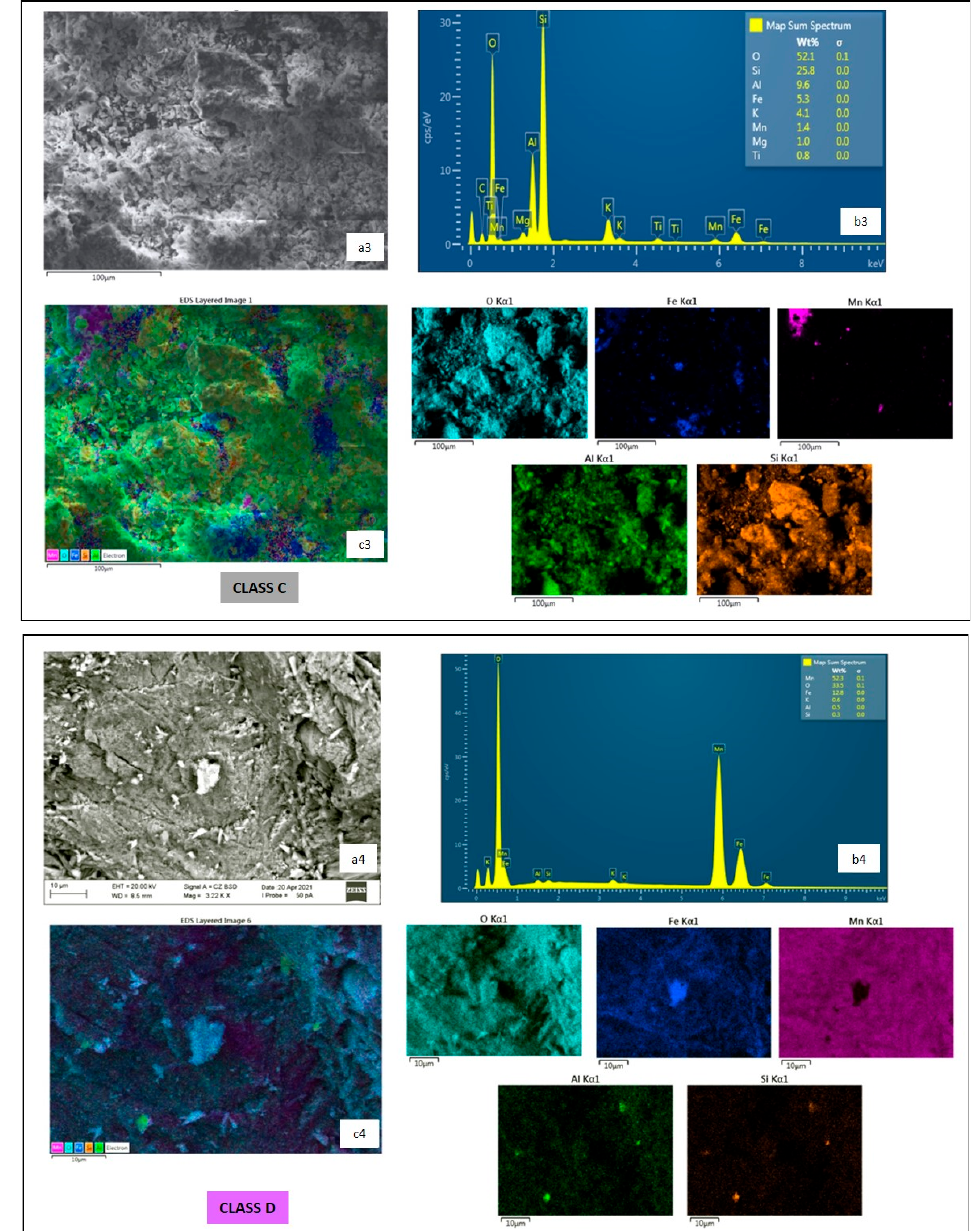
Figure 9. SEM-EDS results for Class A, Class B, Class C and Class D. In particular, for each class, SEM-BSD images ( a ), EDS spectra ( b ) and the X-ray maps ( c ) were acquired.